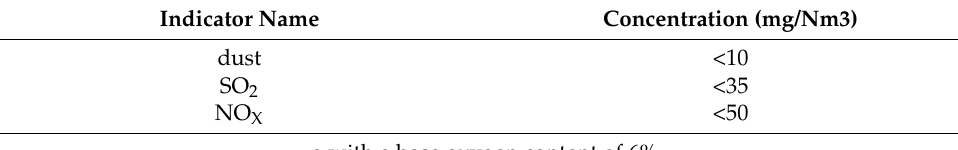
Table 4. Environmental performance of different boiler load above 20%